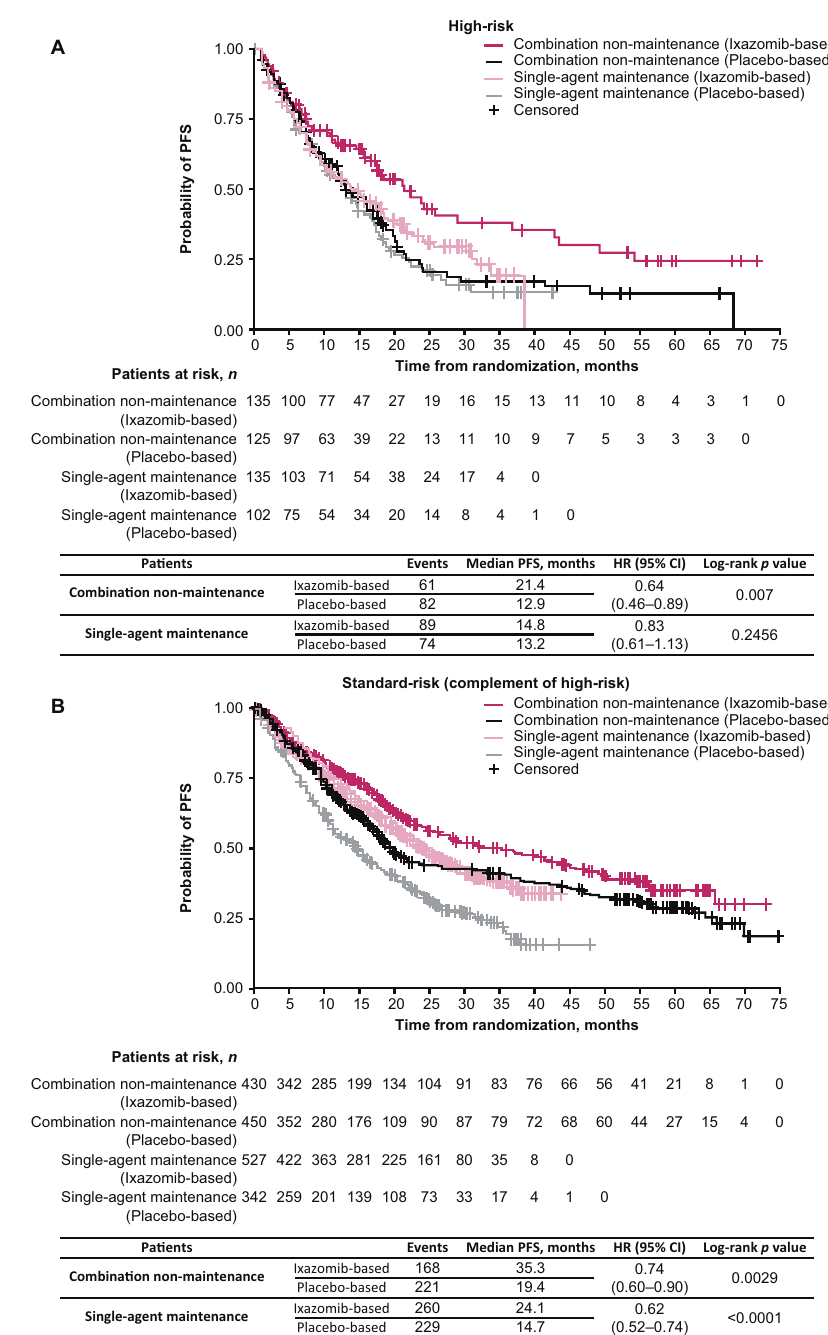
Fig. 6 Kaplan – Meier estimates of PFS for patients receiving ixazomib- vs placebo-based therapy as single agent maintenance vs combination non-maintenance. A High-risk cytogenetic abnormalities, and B standard risk (complement of high-risk) abnormalities. CI con fi dence interval, HR hazard ratio, PFS progression-free recent publication by Paiva et al. evaluates the implications of number for chromosome 1 abnormalities evaluated in this analysis MRD in the TOURMALINE-MM3 and TOURMALINE-MM4 study was not speci fi ed. A recent publication focusing on the lack of populations [35]. Another limitation is the use of inconsistent cut- uniformity of categorizing patients with additional copies of 1q as off values for de fi ning the presence of high-risk cytogenetic high-risk highlights the importance of copy number of 1q as a abnormalities across the four studies in this analysis, limiting driver of poor outcomes in MM [34]. As such, further study that cross-trial comparisons. At present, there is no standardized FISH- includes the patients ’ copy number of 1q is needed in order to positivity cut-off value for de fi ning the presence of del(17p) determine the impact of this abnormality on treatment outcomes. [12, 23]. It is currently unclear what minimum percentage of Furthermore, data on measurable residual disease (MRD) were not del(17p)-positive cells is associated with a poor prognosis, or collected for all four studies, thus an analysis of the relationship whether this varies depending on treatment used and stage of between MRD and cytogenetics cannot be conducted; however, a